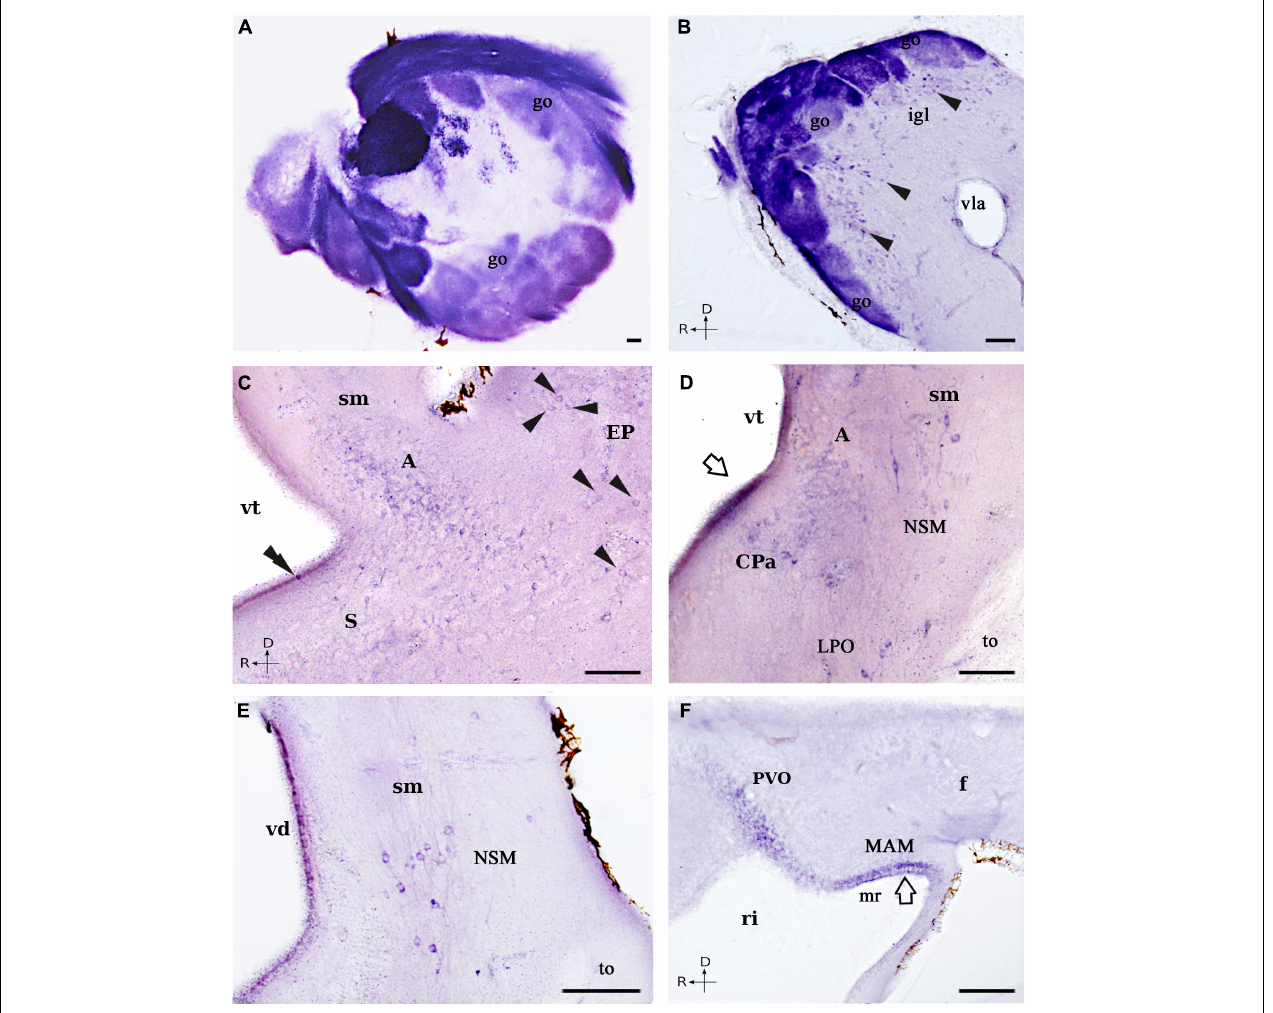
FIGURE 3 | Photomicrographs showing NADPH-d positive cells and fibers in the forebrain of L. fluviatilis . (A,B) Transverse (A) and sagittal (B) sections showing a strong NADPH-d staining in most of the primary olfactory fibers and the olfactory glomeruli. Note that particular glomeruli show different intensities of reaction, as well as the presence of positive mitral cells (arrowheads) bordering the glomeruli in (B) . (C) Transverse section showing NADPH-d positive cells in the amygdala (A), the dorsal striatum (S), and the evaginated pallium (EP; arrowheads). A positive CSF-c cell is present in the striatum (double arrowhead). (D) Transverse section showing NADPH-d positive cells in the caudal amygdala (A), the nucleus of the stria medullaris (NSM), the caudal paraventricular area (CPa), and the lateral preoptic nucleus (LPO). The open arrow points to the periventricular staining. (E) Transverse section illustrating part of the cells included in the nucleus of the stria medullaris (NSM). (F) Sagittal section showing weak NADPH-d labeled cells in the hypothalamic periventricular organ (PVO) and in the mamillary region sensu lato (MAM), as well as positive fibers in the fasciculus retroflexus (f). Medial and rostral directions are oriented to the left in transverse and sagittal sections, respectively. For abbreviations, see list. Scale bar = 50 µ